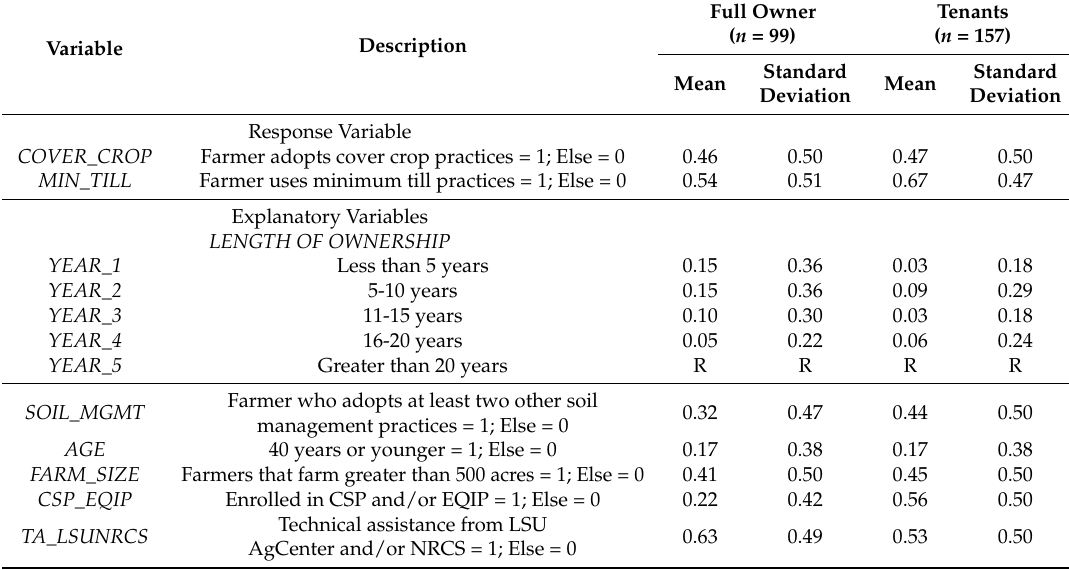
Table 2. Variable Definitions and Descriptive